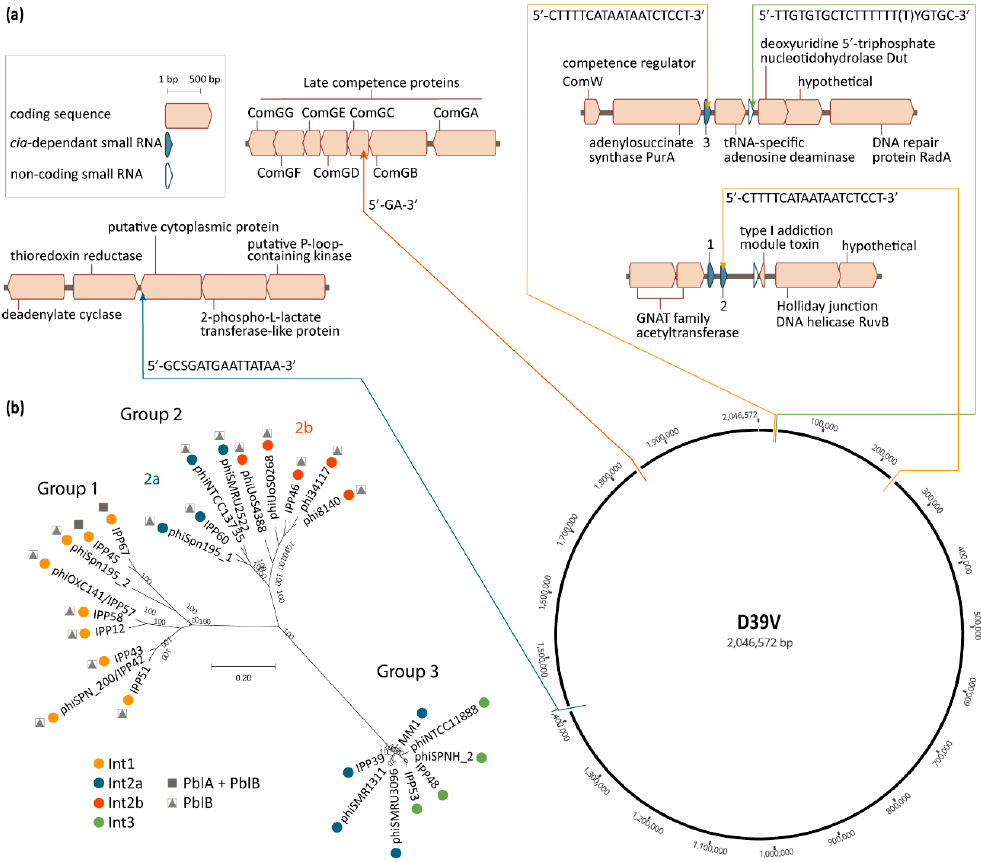
Figure 2. Pneumococcal temperate phage groups and their chromosomal integration loci. ( a ) Chromosomal integration sites of pneumococcal phages. Thin arrows indicate the precise locus of the phage attachment sites, in relation to their immediate genetic context and their location on the circular representation of the D39V (CP027540.1) genome. Direction of the arrows reflects the orientation of phage integration in the chromosome respective to the integrase being located at the 5 ′ end of the integrated phage, as is the convention. Color of the arrows and connecting lines refer to the integrase type in panel (b). The nucleotide sequence of each core attachment site is indicated at each integration locus, as previously defined by Romero et al., [26] (Int1) and Gindreau et al., [24] (Int2a, including modifications reflecting single nucleotide polymorphisms in the genomes used in panel (b)), or as determined by the authors by aligning the left and right phage–chromosome junctions with the corresponding chromosomal site in the genome of D39V, in the case of Int3 and Int2b; ( b ) phylogenetic tree of a selection of pneumococcal temperate phages for which the genetic context could be determined. The multiple alignment of phage genomes was performed using MUSCLE v.3.8 [60]. The phylogenetic tree was constructed using FastTree v.2.1.10 [61] and visualized in MEGA-X v10.1.8 [62]. Colored dots represent the integrase type according to the key, and refer to the similarly-colored arrows pointing to the integration sites in panel (a). All Int1-encoding phages depicted here, except for IPP67, integrate in csRNA3. The presence of genes encoding the putative virulence factors PblA and PblB is indicated. Accession numbers of the sequences used are listed in Appendix A, Table A1. Based on sequence similarity, four major integrase types are found in pneumococcal phages. Int1, Int2a, and Int3 belong to the tyrosine recombinase family, while Int2b belongs to the serine recombinase family. These integrases are each associated with specific core sites which can be found